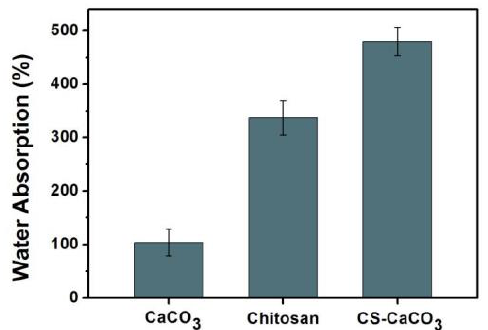
Figure 4. Water absorbability of CaCO 3 and CS–CaCO 3 .